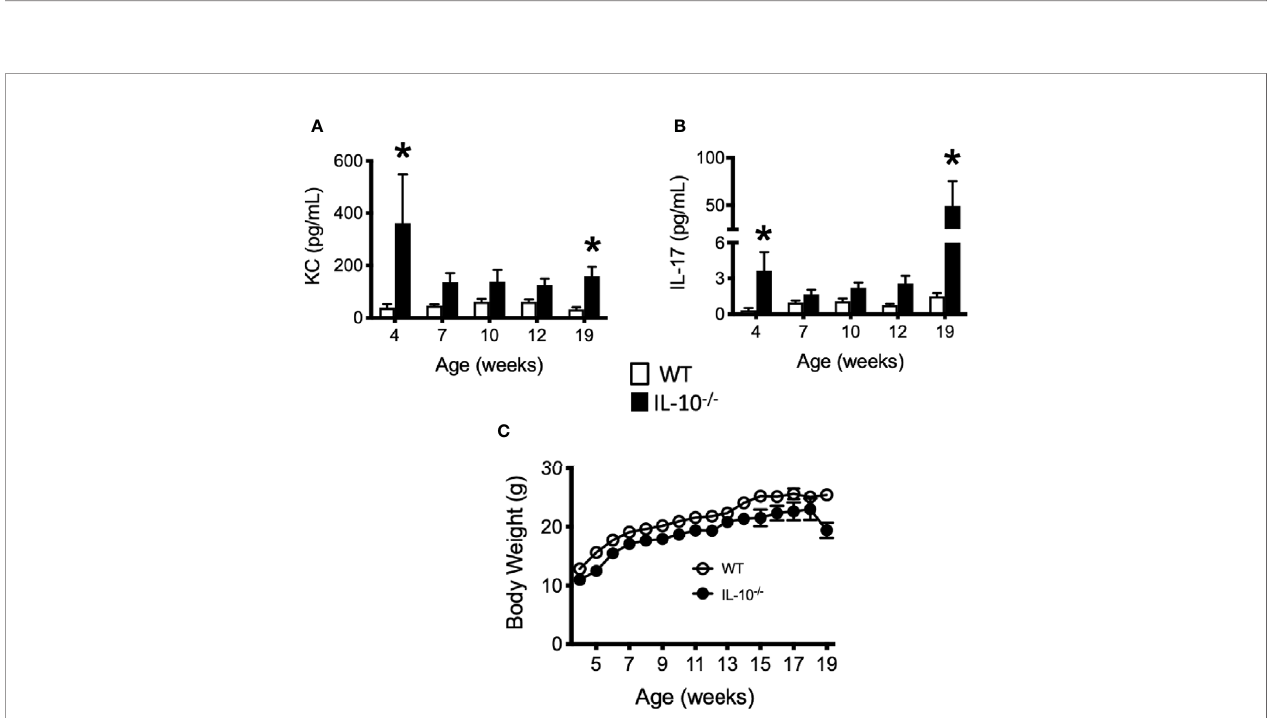
FIGURE 7 | Levels of cytokine and chemokines that were elevated in the serum of IL-10 -/- mice at 19 weeks of age. Concentrations of KC (A) and IL-17 (B) were measured in the serum of wild type (white bars) an IL-10-/- mice. Whole body weights of WT and IL-10 -/- mice during the 19 week trial (C) . Data are presented as mean ± SEM. Both groups of mice gained a similar amount of weight between weeks 4 and 18 of age (IL-10 -/- = 12.0 g, WT = 12.2 g). At each time point, there were equal numbers of WT and IL-10 -/- mice included in the analysis. The number of mice used for each strain at each time point varied as follows: at 4 weeks of age, n = 5; at 7 weeks of age, n = 10; at 10 weeks of age, n = 9; at 12 weeks of age, n = 13; at 19 weeks of age, n =